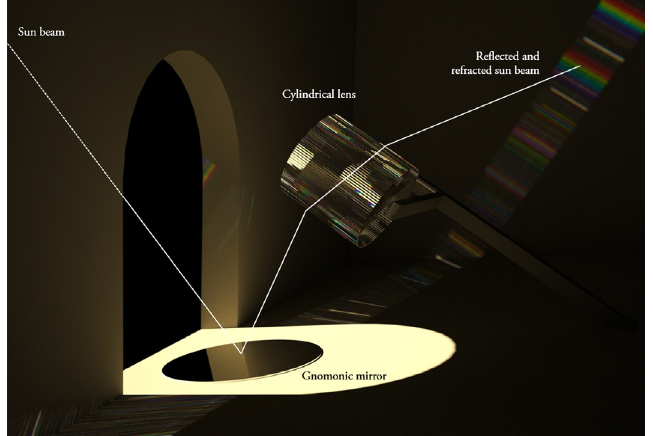
Fig. 2 Explanation of Iride Horariae Dioptricae by Maignan (digital reconstruction by the